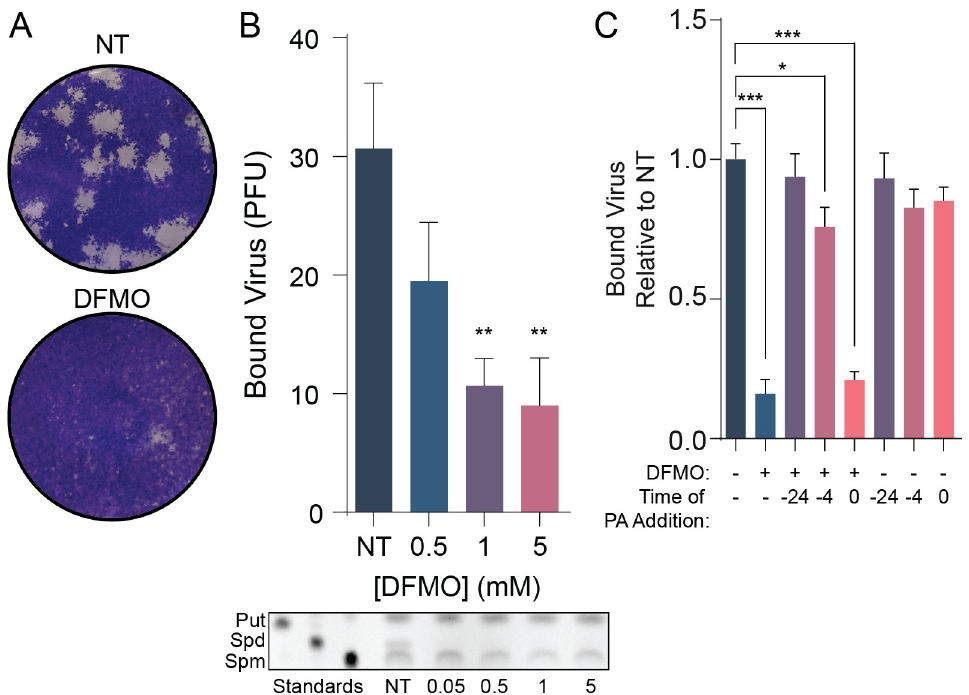
Fig 1. CVB3 requires polyamines for attachment. (A) Representative plaques from B. (B) (Top) Quantification of plaques formed from a CVB3 binding assay with DFMO treated Vero cells. (Bottom) Thin layer chromatography of Huh7 cells treated with increasing doses of DFMO. (C) Vero cells were treated with DFMO for 96 hours then treated with 10 μ M equimolar ratio of polyamines at the indicated times before infection. * p < 0.05, ** p < 0.01, *** p < 0.001 by the Student’s t test. Data from at least three independent experiments. Error bars represent standard